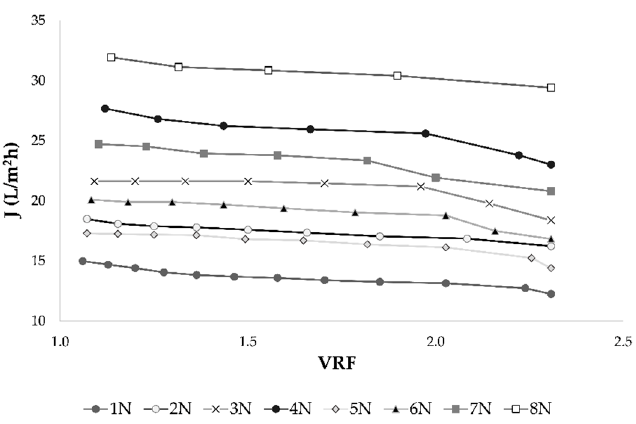
Figure 2. Influence of volume reduction factor (VRF) on permeate flux J (L/m 2 h) during nanofiltration process of conventional and ecological Cabernet Sauvignon red wine.